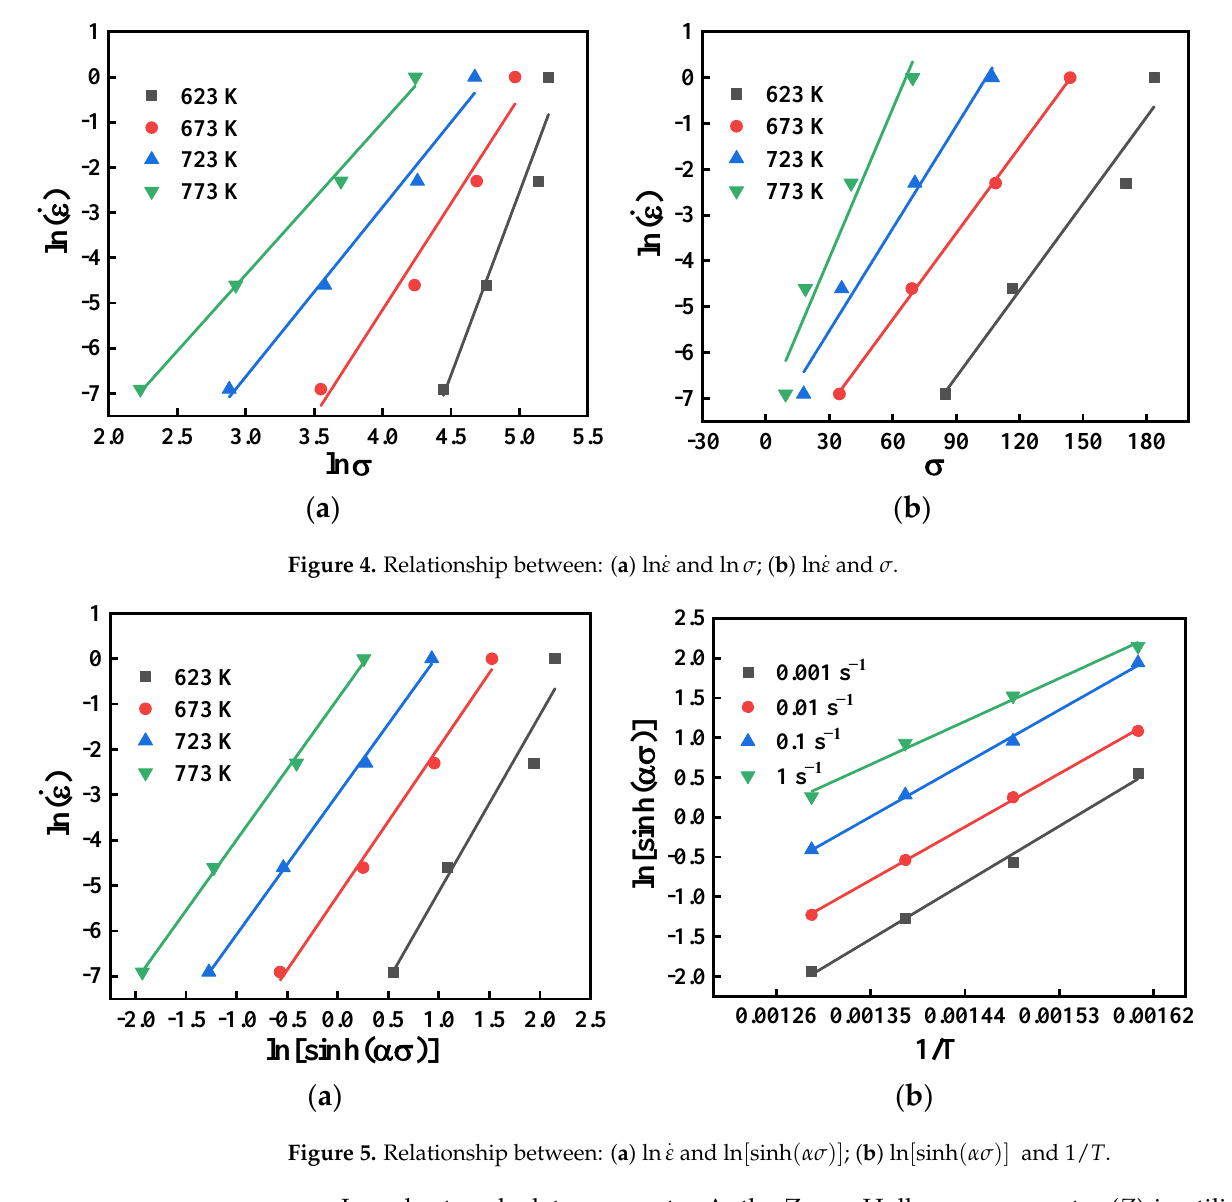
which is expressed as follows: